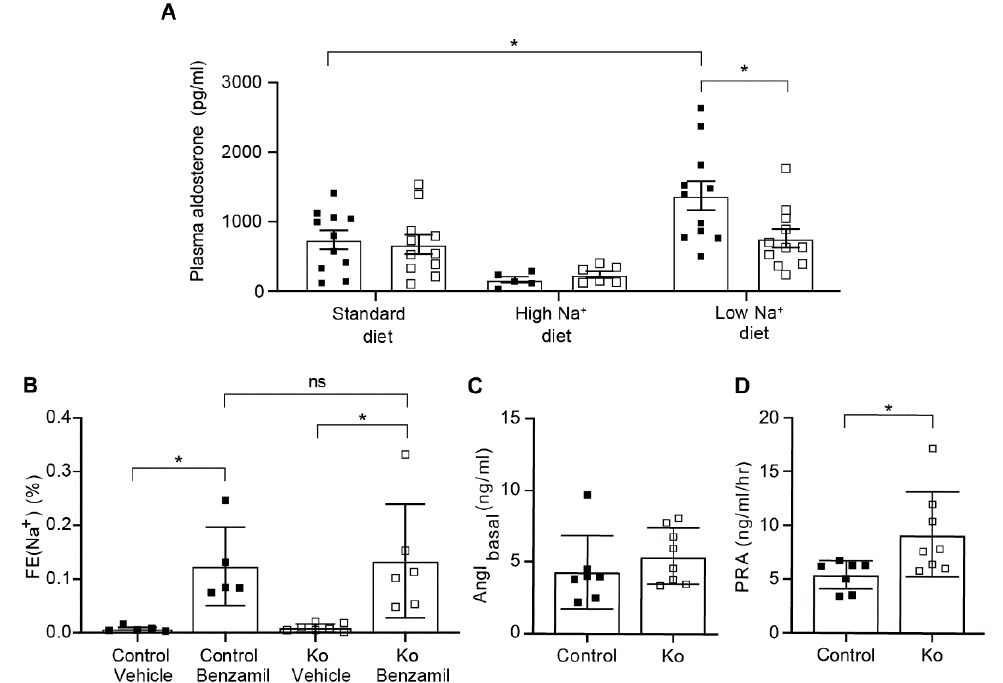
Figure 5. Prss8 PaxLC1 Ko mice exhibited a decrease in plasma aldosterone concentration and an increase in plasma renin activity under low Na + diet. ( A ) Plasma aldosterone levels in control (black square) and knockout mice (Ko, white square) under standard, high and low Na + diet. ( B ) Natriuretic response expressed as fractional excretion of Na + (in %) in control (black square) and knockout mice (Ko, white square) treated with vehicle or acute treatment of benzamil (0.2mg/kgBW). ( C ) Measurement of basal plasma angiotensin I concentration (determined at 4 °C) and ( D ), plasma renin activity (PRA) expressed as amount of angiotensin I following enzymatic cleavage of the renin substrate angiotensinogen (at 37 °C) in Prss8 PaxLC1 control (black square) and knockout mice (Ko, white square). ( A , C , D ) were analyzed by an unpaired two-tailed t test. ( B ) was analyzed by a two- way ANOVA with a Sidak’s multiple comparisons test (column factor: genotype; row factor: treat- ment). ( A ) Results are represented as mean ± SEM (2 series of experiment, control n = 5 – 11, Ko n = 6 – 11). ( B – D ) Results are represented as mean ± SD. p values < 0.05 were considered statistically significant. * p < 0.05. Application of losartan, an angiotensin II type 1 receptor blocker, did not change the plasma Na + and plasma K + concentrations between the control and knockout group on low Na + diet, although there was a trend to lower plasma K + levels in the losartan-treated knockout group (data not shown). Furthermore, the losartan treatment significantly re- duced the plasma aldosterone concentration in control, but not in Prss8 PaxLC1 knockout mice (Figure 6A). Following losartan treatment, a further benzamil-induced block of ENaC revealed equally increased fractional excretion of urinary Na + indicative for a simi- lar ENaC activity in both control and knockout mice (Figure 6B).